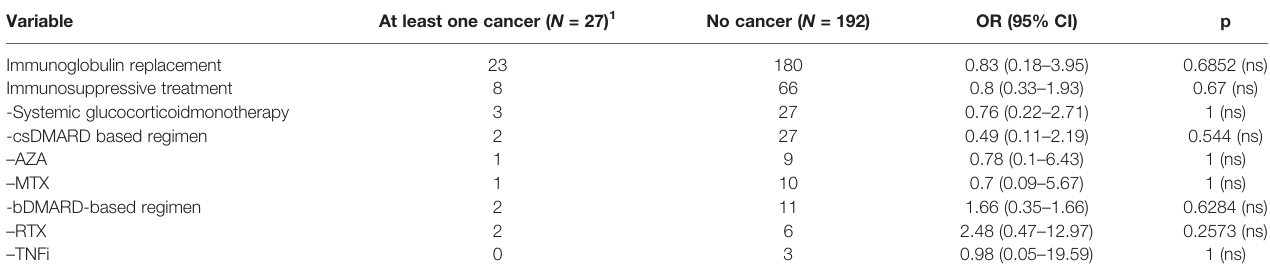
TABLE 4 | Association of patients ’ treatment with cancer.